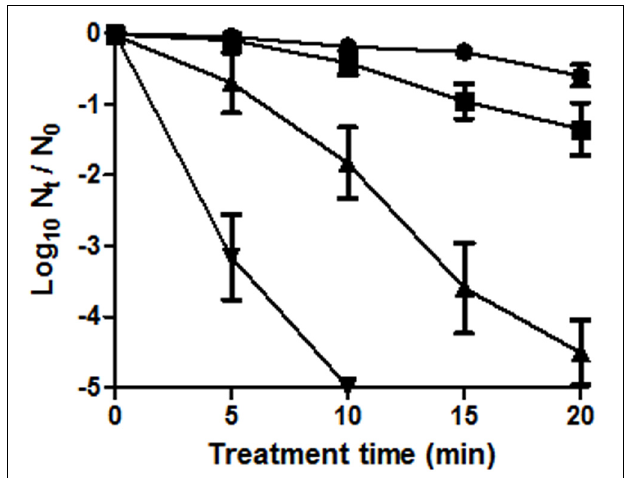
FIGURE 1 | Survival curves of Escherichia coli BW25113 (initial concentration: 10 8 CFU/mL) to a heat treatment at 55 ◦ C in M9 broth for different treatment times. E. coli cells were cultured in M9 agar (non-selective agar) ( ) or M9 agar supplemented with 1 ( (cid:4) ), 2 ( (cid:78) ), or 3% ( (cid:72) ) NaCl. Error bars represent standard deviation of the mean from (cid:32)